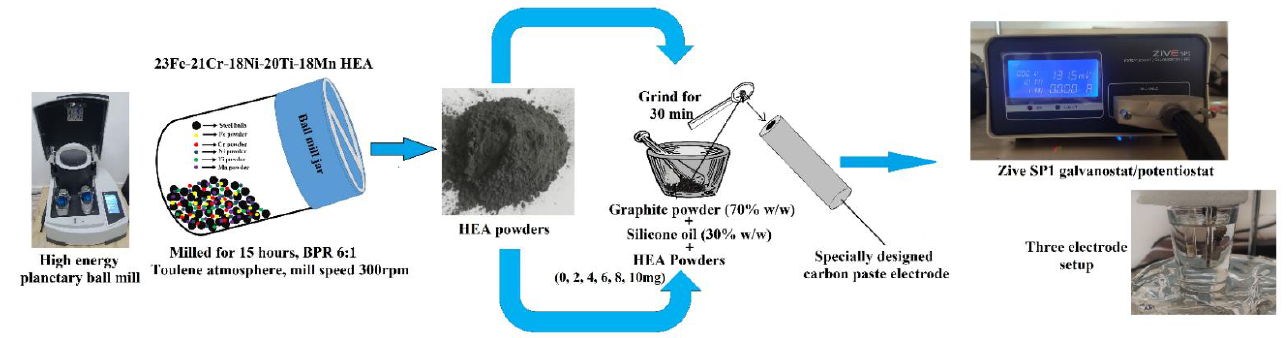
Figure 1. Graphical representation of the experiment.